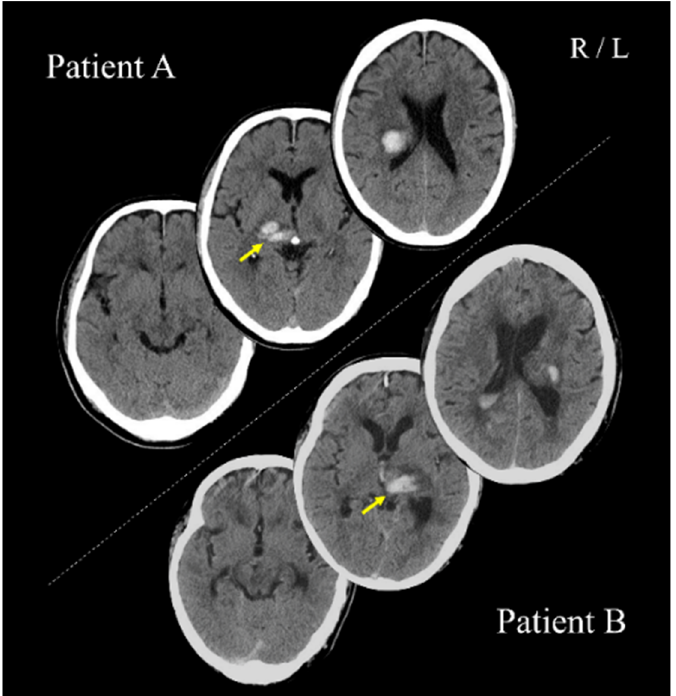
Figure 1. Computed tomography scans show the lesion sites of patients A and B. These images were acquired within a day after stroke onset. Yellow arrows indicate the lesion sites. R: right hemisphere; L: left hemisphere.